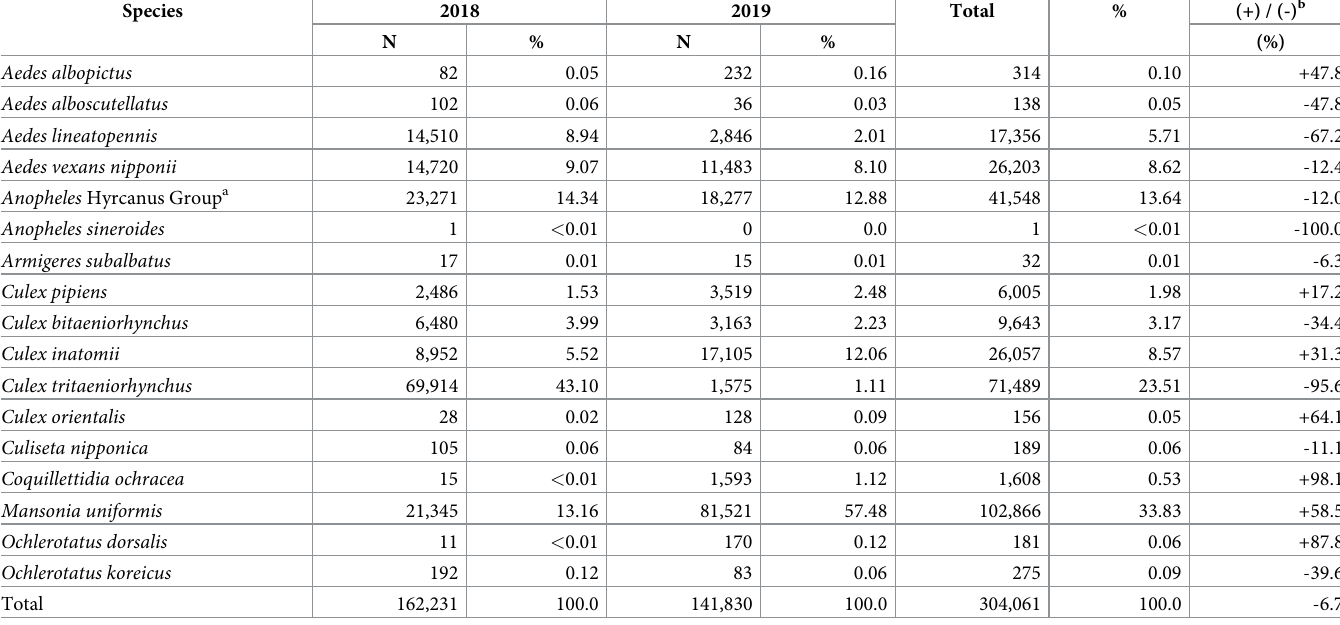
Table 3. Total number and percentage of mosquitoes collected by species at USAG Humphreys using Mosquito Magnet 1 Independence 1 model traps during 2018 and 2019 mosquito season from